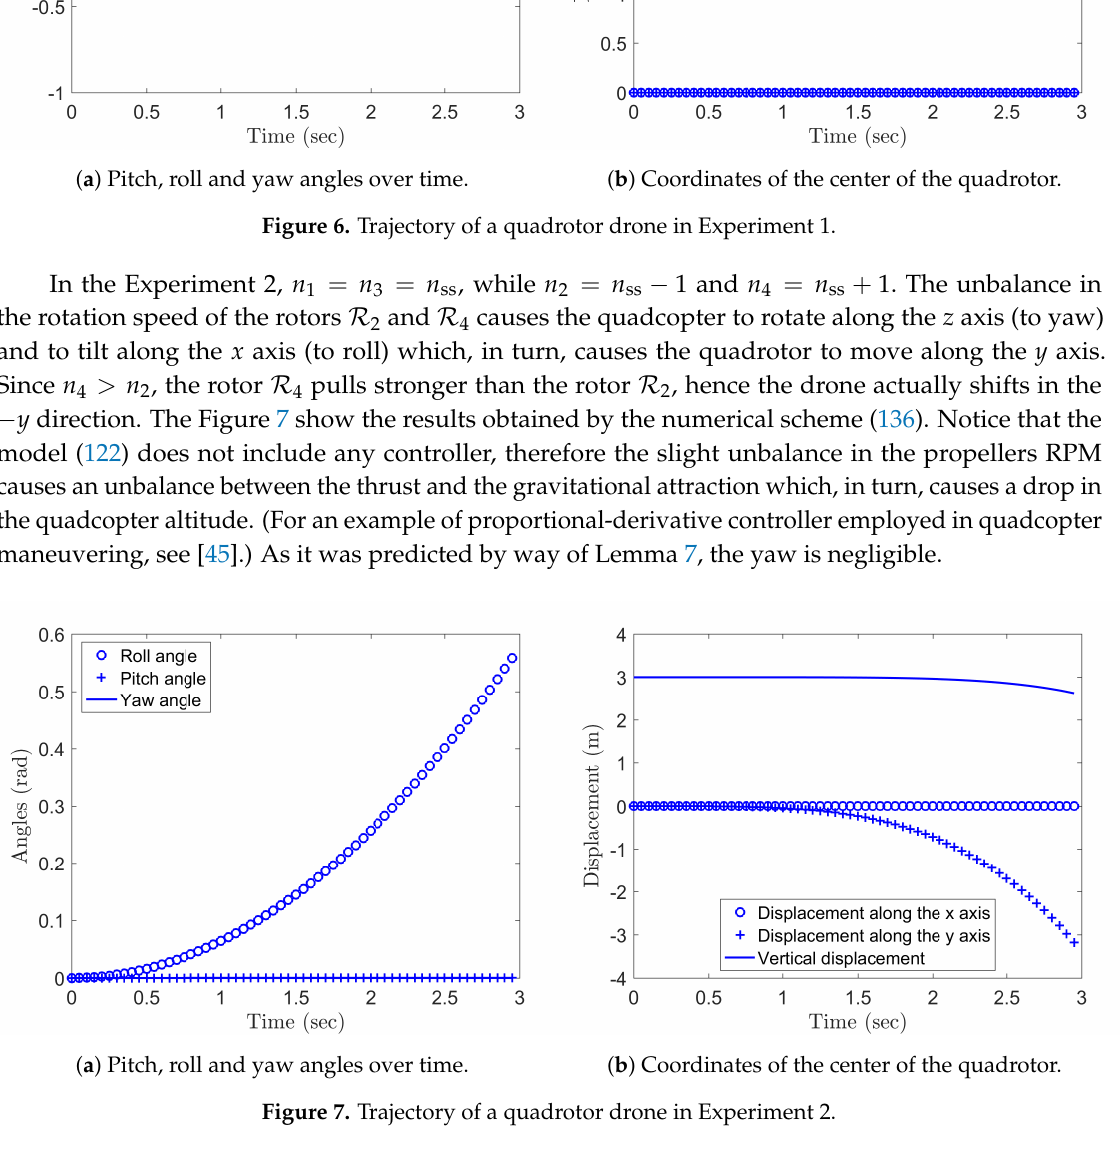
Figure 7. Trajectory of a quadrotor drone in Experiment